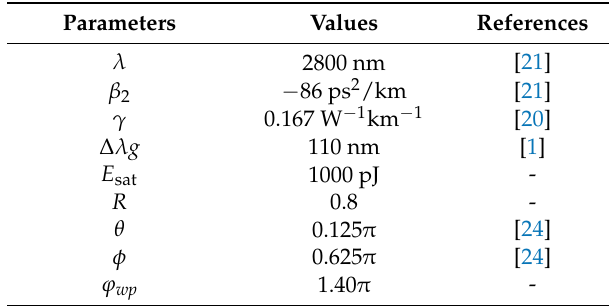
Table 1. Parameters used in the simulations.